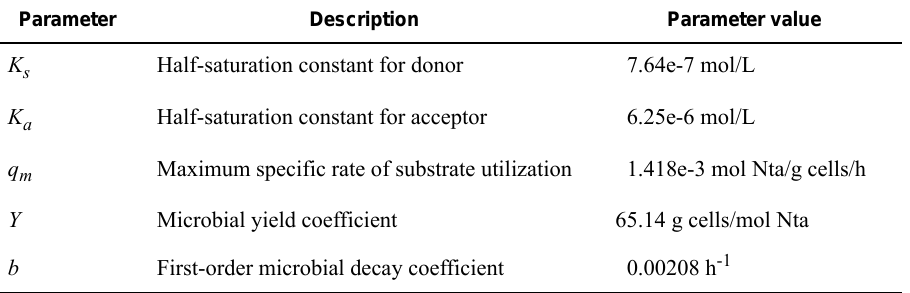
Table 42. Kinetic rate parameters used in example 15. [mol, mole; L, liter; g, gram; h,